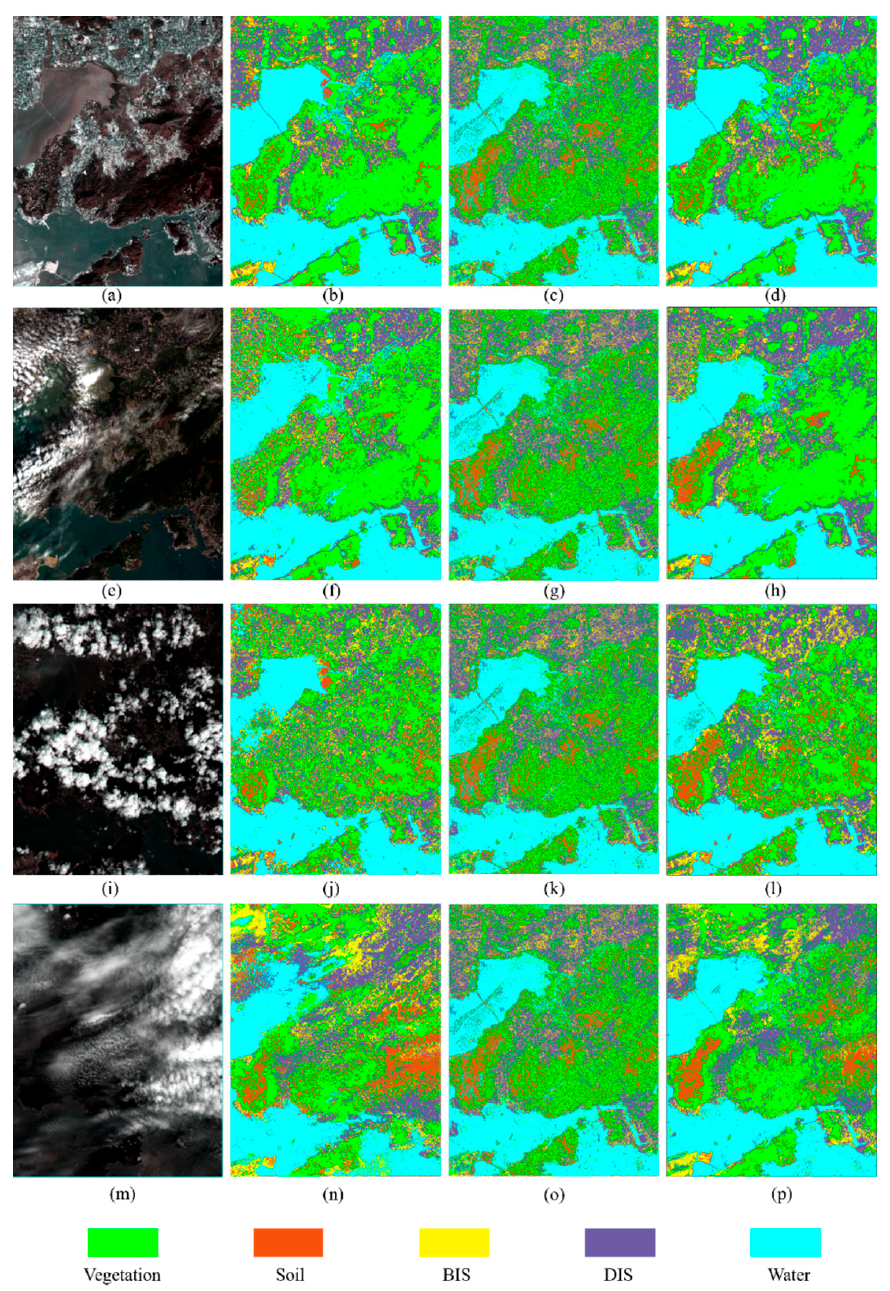
Figure 3. Land cover classification with different levels of cloud coverage. ( a , e , i , m ) are the cloud- contaminated optical images with cloud coverage of 0, 6%, 30%, and 50%, respectively, ( b , f , j , n ) are the land cover classification maps of single optical images, ( c , g , k , o ) are the land cover classification maps of single SAR images, and ( d , h , l , p ) are the land cover classification maps of fused optical and SAR images.